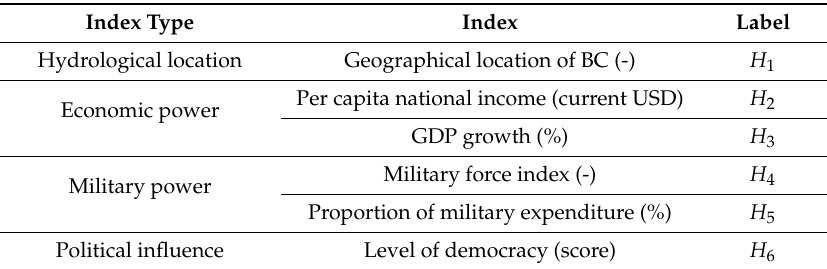
Table 2. Asymmetric powers in the negotiations among basin